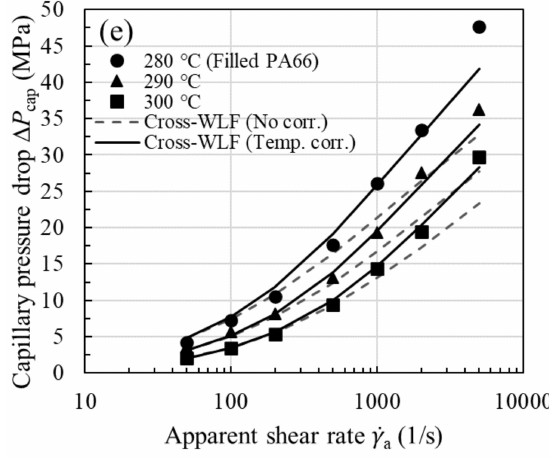
Figure 7. Measured capillary pressure drop ∆ P cap (symbols, L / D = 30) vs. viscous Cross-WLF model prediction based . γ ) with and without temperature correction (lines) as a function of on η ( ( e ) filled PA66.